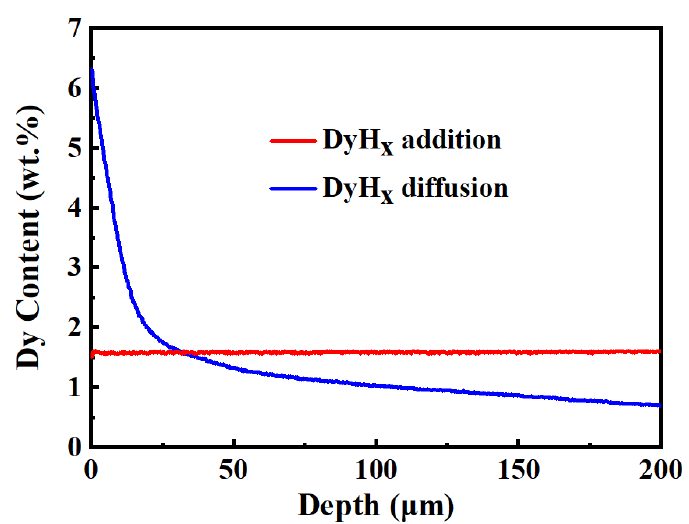
Figure 2. The Dy concentration distributions of the DyH x addition and diffusion magnets in the depth range of 0–200 μ m.